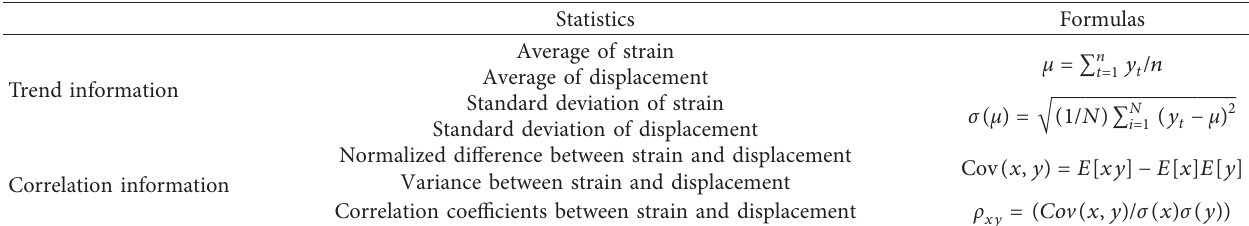
Table 4: Statistics and formulas.